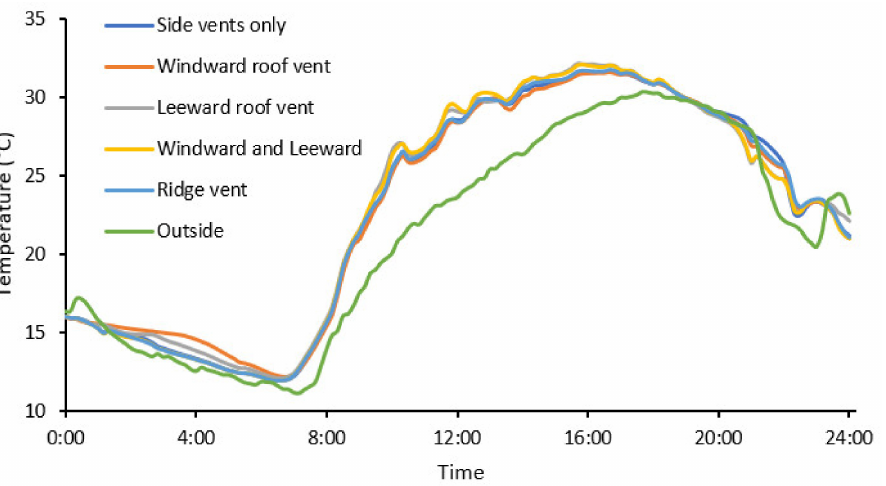
Figure 10. Simulated temperatures inside a high tunnel outfitted with different roof vent designs, averaged over the respective cross-sections depicted in Figure